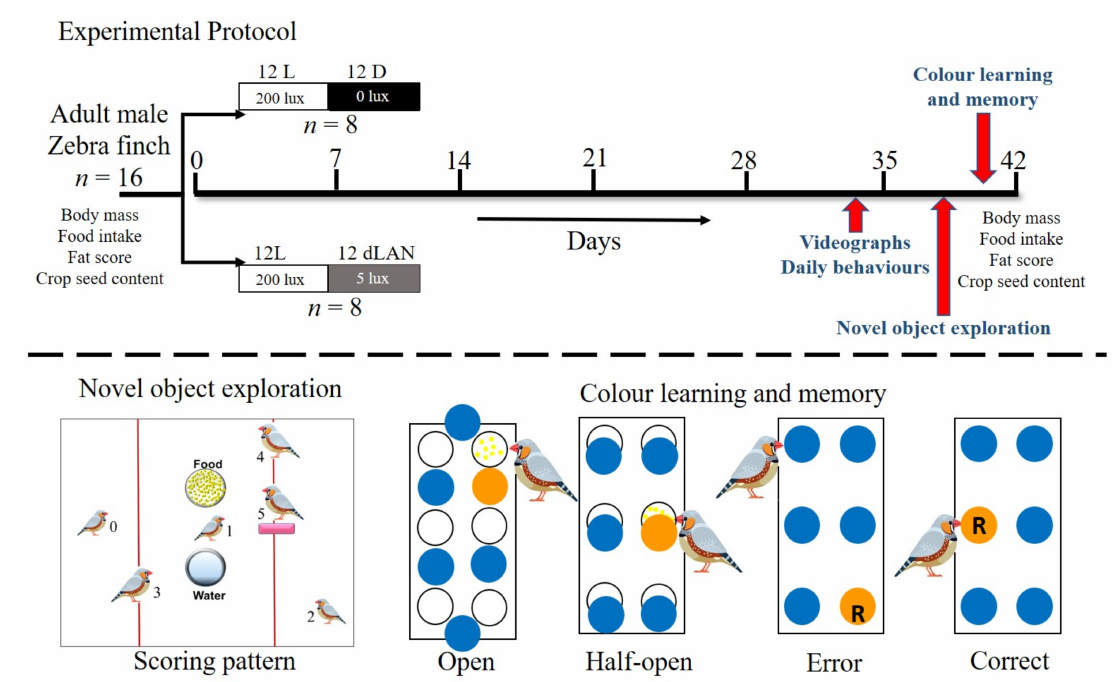
Figure 1. Experimental protocol: Adult male zebra finches, Taeniopygia guttata ( n = 16) were subjected to dim light at night (L: 200 ± 10 lux, dLAN = 5 ± 1 lux) or darkness at night (L: 200 ± 10 lux, D < 0.1 lux) for six weeks at 22 ± 2 ◦ C with food and water ad libitum. We recorded physiological parameters (body mass, food intake and fat score) and crop seed content at the start and end of the experiment. We videographed daily behaviors of birds at the end of week five. Birds were tested for novel object exploration and colour learning and memory task at the end of week six (for details see materials and methods